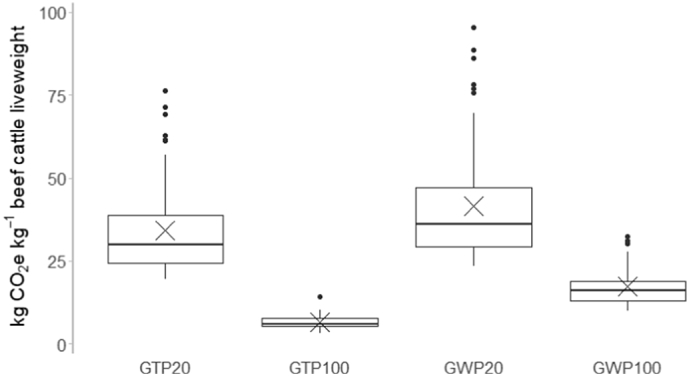
CO2e footprints of beef cattle production under alternative metrics.